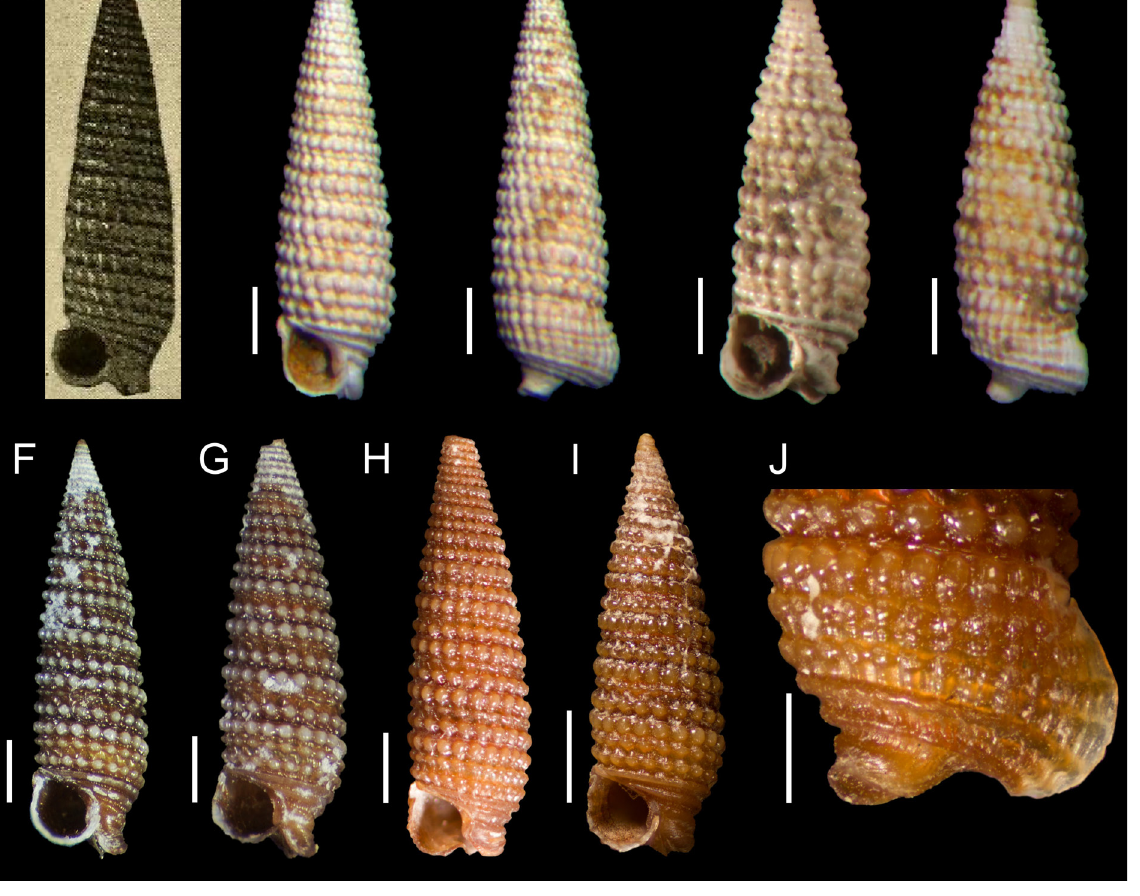
Fig. 1. Cheirodonta dupliniana (Olsson, 1916). A–C . PRI 1376, 5.75 mm (original description) or 6.31 mm (scale bar provided), lectotype, illustrated in Olsson (1916). D–E . PRI 11016, 5.57